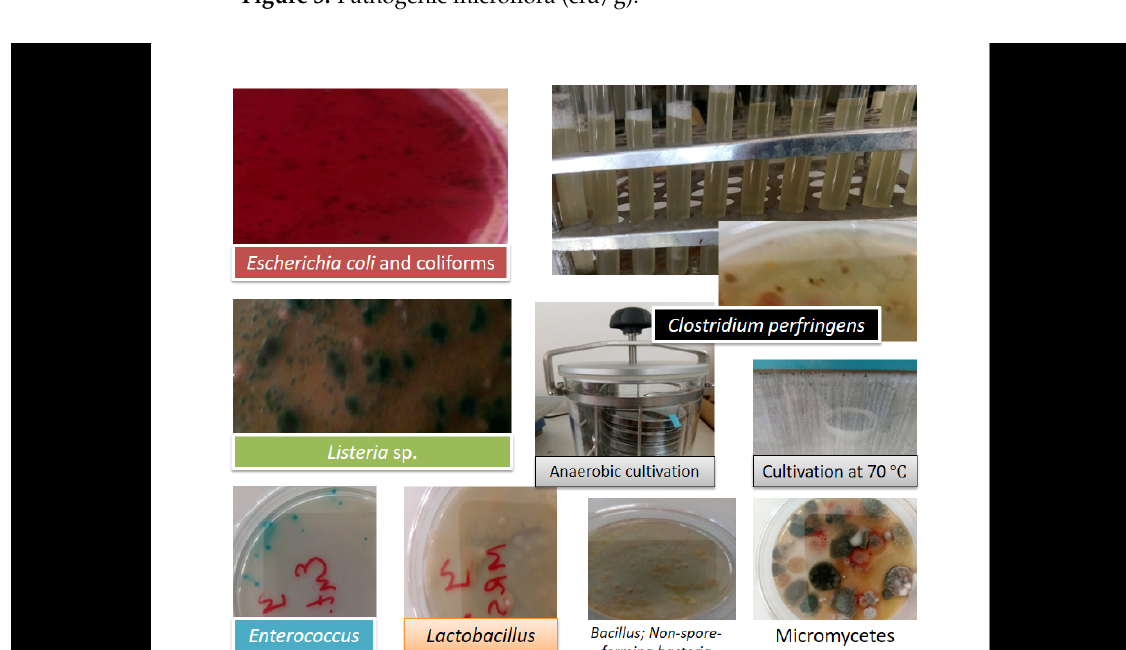
Figure 3. Pathogenic microflora (cfu/g).